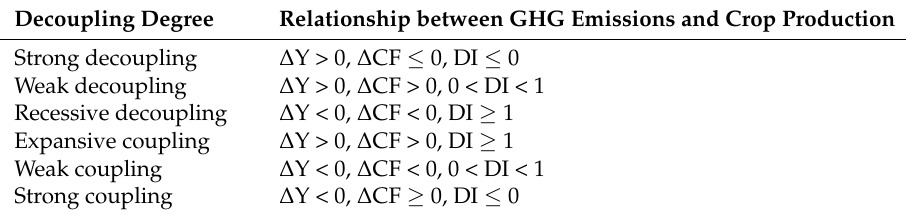
Table 2. Degrees of decoupling GHG emissions from crop